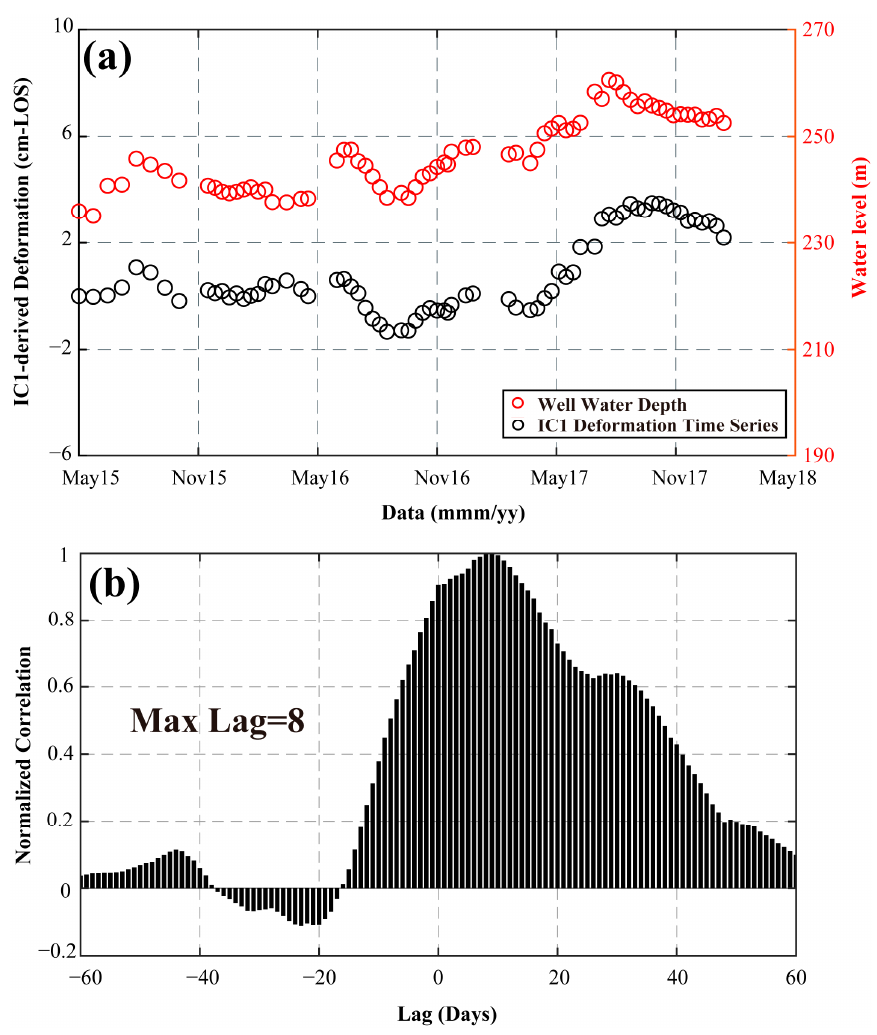
Figure 10. ( a ) Comparison between the IC1-derived deformation time series and groundwater levels. The red dots represent the water level and the black dots represent the IC1-derived deformation time series. ( b ) Cross-correlation coefficient between the IC1-derived deformation and groundwater level.